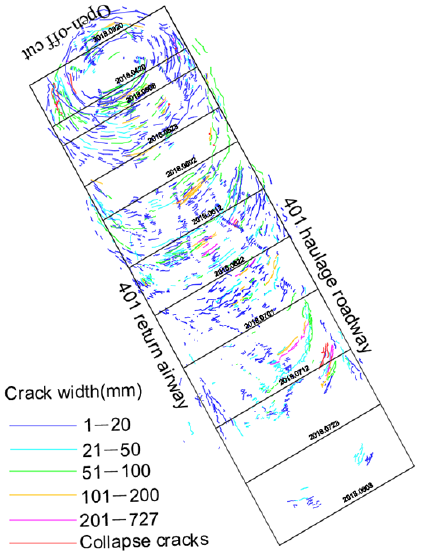
Figure 19. Distribution map of cooperative monitoring cracks at 401 working face of Shangwan Mine